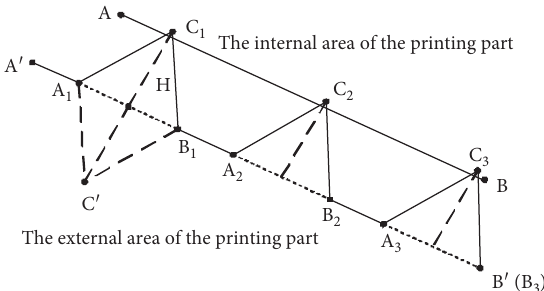
1 (P) 2 diagram. Figure 6: The diagram of the novel platform attached support